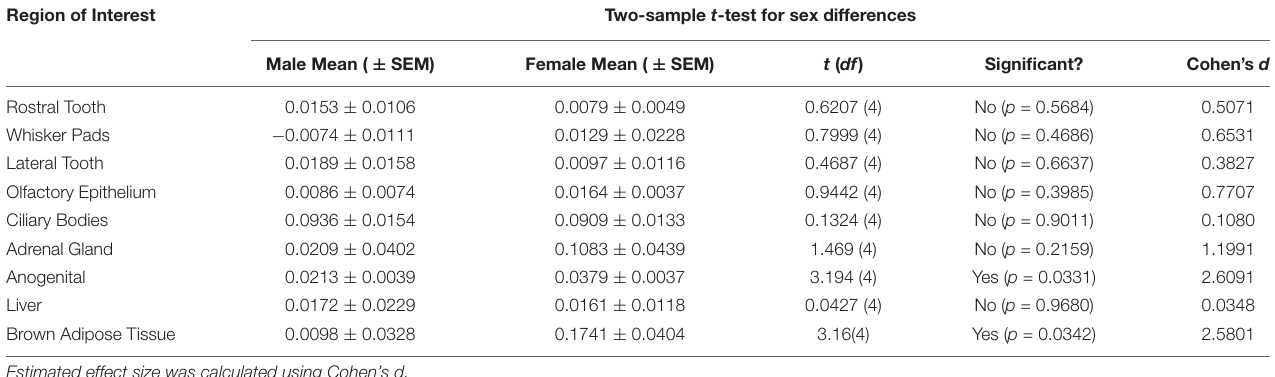
TABLE 2 | Significant differences ( p < 0.05) between sexes were observed in the anogenital area and the brown adipose tissue.